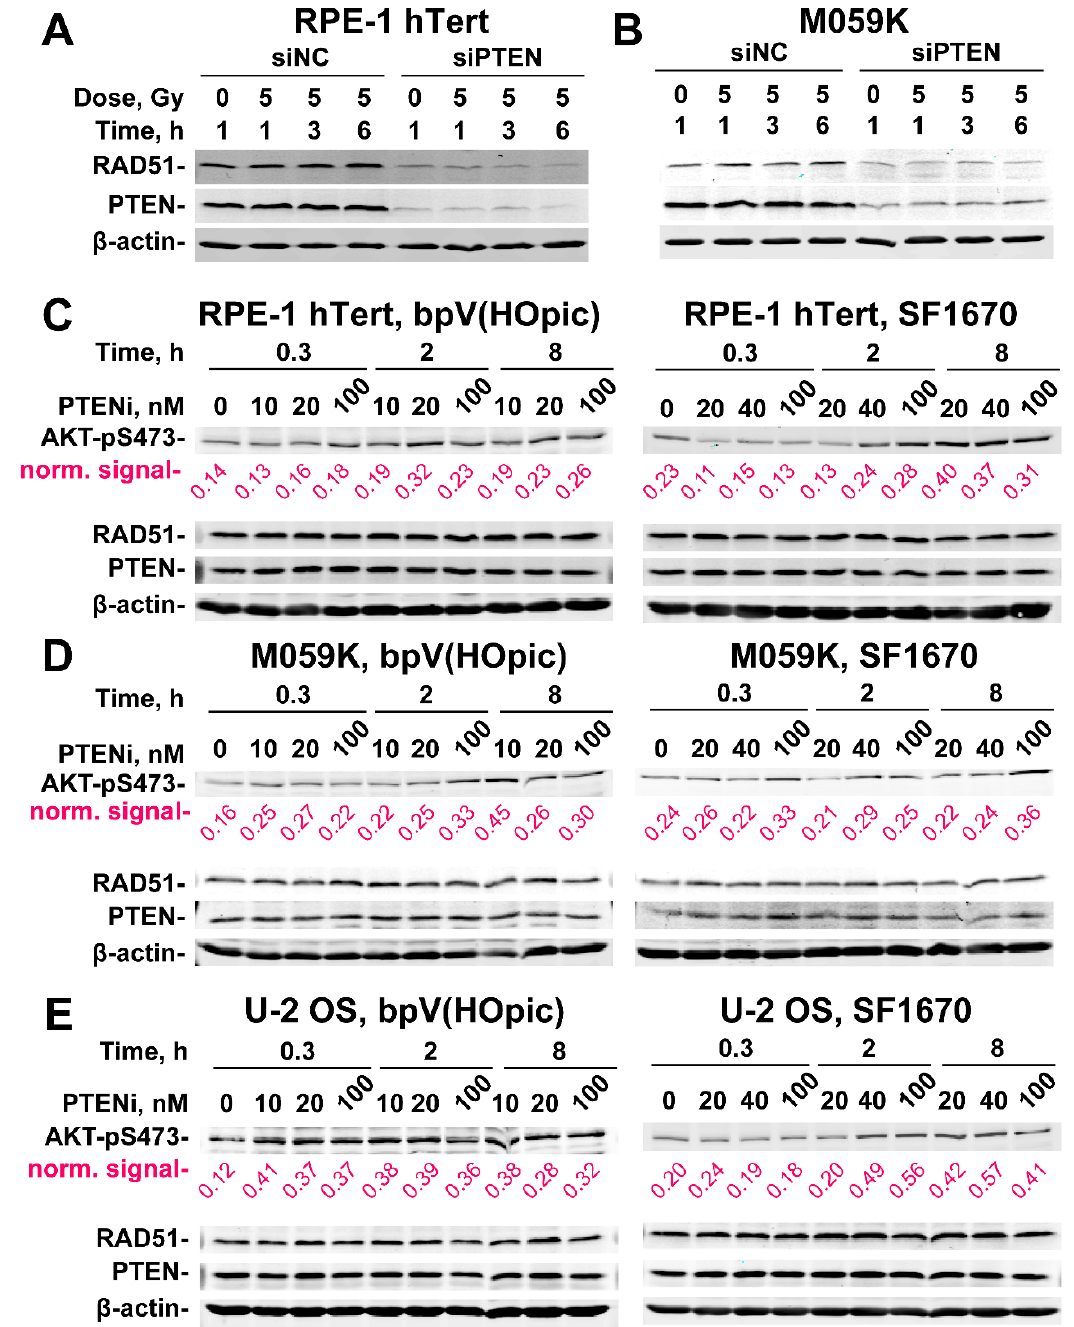
Figure 5. PTEN knock-down suppresses RAD51 expression. ( A ) Effect of PTEN deficiency on RAD51 expression in RPE-1 hTert cells. β -Actin serves as loading control. ( B ) Same as panel ( A ), but for M059K cells. ( C ) Western blot analysis of AKT-pS473, PTEN and RAD51 protein levels in RPE-1 hTert cells treated with the indicated concentrations of bpV(HOpic) or SF1670 (PTEN inhibitors) for the indicated times. ( D ) Same as panel ( C ), but for M059K cells. ( E ) Same as panel ( C ), but for U-2 OS cells. Densitometry analysis of the gels are shown in Figure S4. The β − actin normalized values obtained from densitometry analysis are indicated in magenta below each lane.